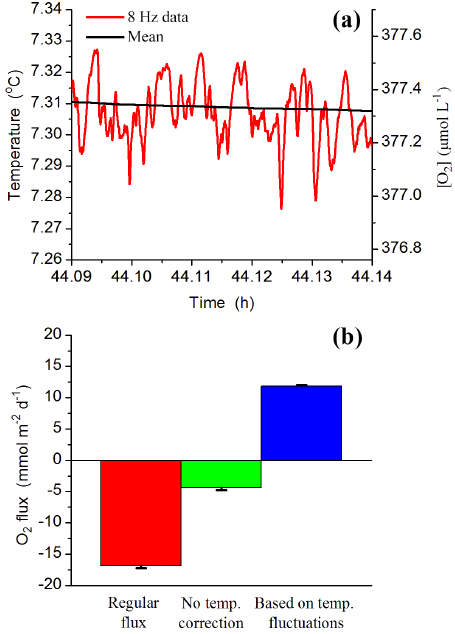
Figure 6. Bias that can arise if O 2 concentration sensor readings are not corrected using rapid parallel temperature measurements. (a) Recorded 8Hz data of temperature fluctuations and their mean (left axis) through 3min and the resulting fluctuations in O 2 con- centration that would be recorded solely due to temperature sensi- tivity by a sensor with a temperature coefficient of 3% (right axis). (b) Average air–water O 2 fluxes, all for the same period of the first night (h18 to h32) of the deployment depicted in Figs. 2 and 3, calculated using instantaneous temperature corrected data (red bar), data without temperature correction (green bar), and “simulated” data produced from 8Hz temperature recordings as shown in panel (a) and assuming a temperature coefficient of 3% (blue